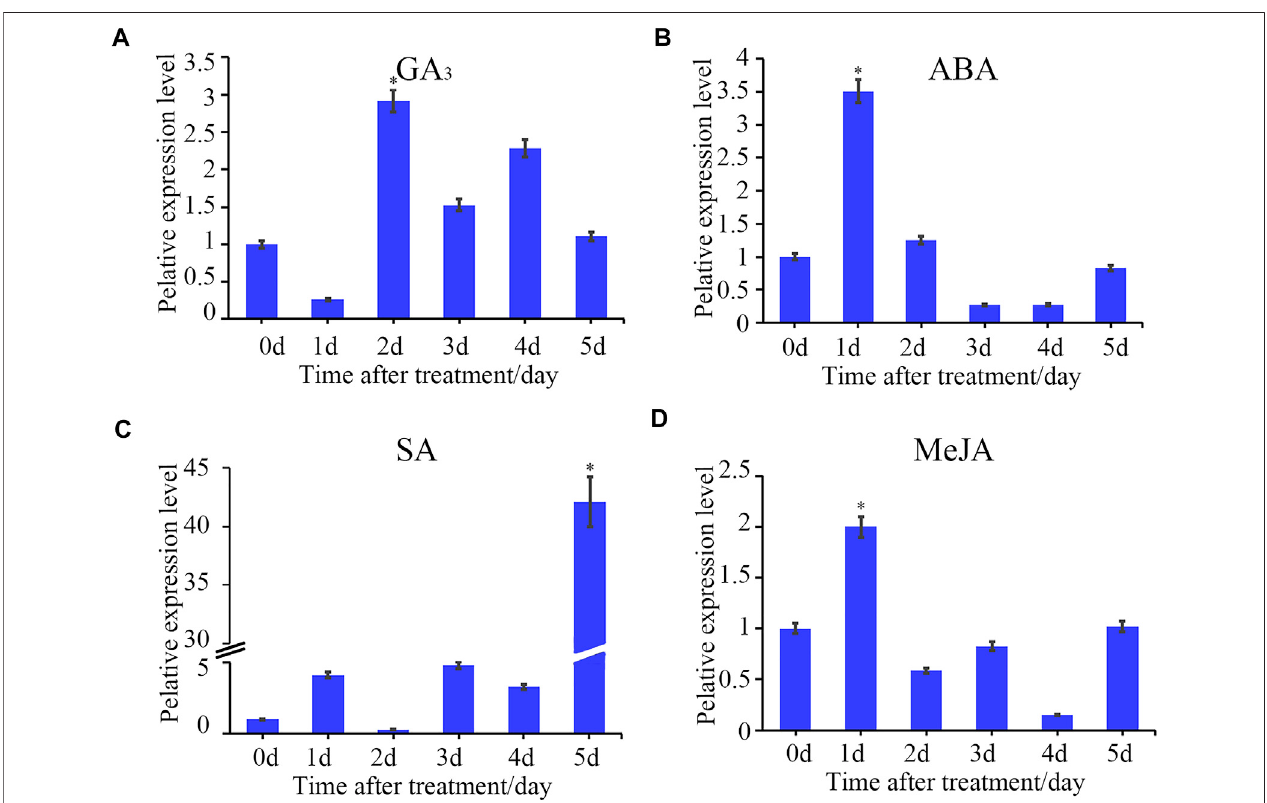
FIGURE 5 | Time-course gene expression pattern of StTGA39 induced by exogenous phytohormones. The relative expression level of StTGA39 at different time points inpotatoinoculated with plant hormones (A) GA 3 , (B) ABA, (C) SA and (D) MeJA wasanalyzed byqRT-PCR.mRNA levels werenormalized to actin (Student ’ s t - test, n = 3 independent experiments, data shown are mean ± standard